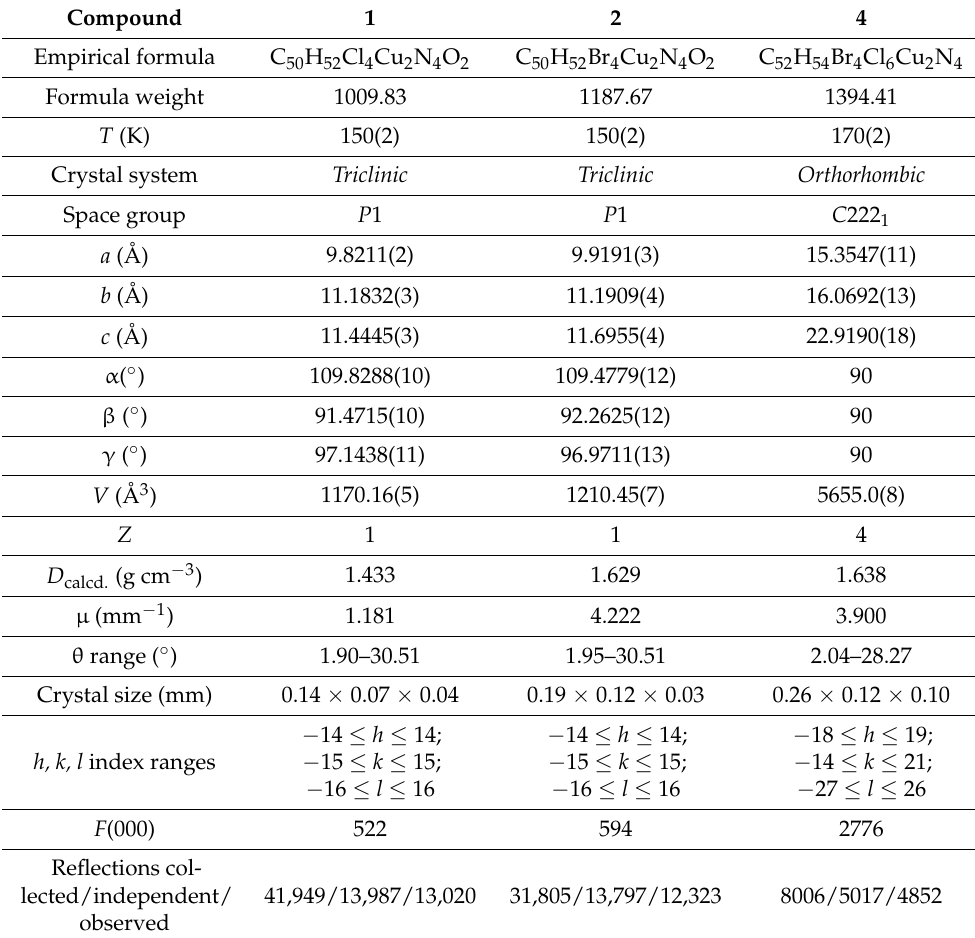
Table 2. Crystal data and structure refinement for 1 , 2 and 4